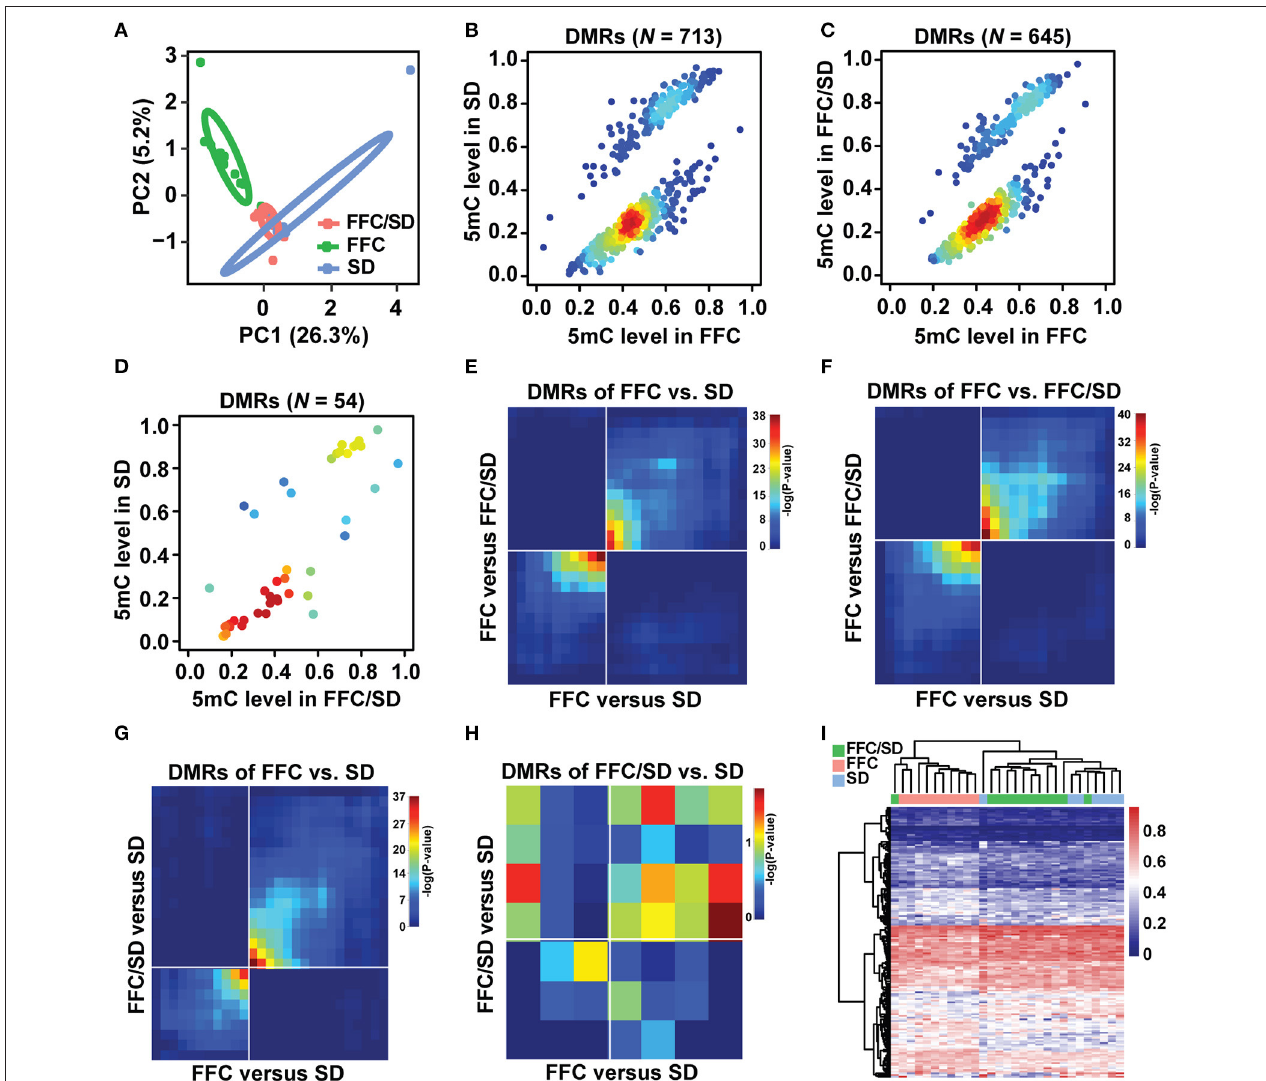
FIGURE 1 | Methylome comparison between different diet fed pigs. (A) Principal component analysis based on 408,458 methylated common CpG sites of three diet groups. Circles representing the three diet feeding groups could be separated at a confidence interval of 68%. (B–D) Scatter plot of methylation level of DMRs in FFC vs. SD (B) , FFC vs. FFC/SD (C) and FFC/SD vs. SD (D) diet fed pigs, with density at each point (red for high density, blue for low density). (E–H) RRHO maps comparing methylation profiles between FFC vs. SD and FFC vs. FFC/SD across DMRs of FFC vs. SD (E) and in FFC vs. FFC/SD (F) , and between FFC vs. SD and FFC/SD vs. SD across DMRs of FFC vs. SD (G) and of FFC/SD vs. SD (H) . (I) Heatmap depicting the hierarchical clustering of methylation level of promoter regions of core genes ( N = 160) that exhibited significant overlap between FFC vs. SD and FFC vs. FFC/SD.